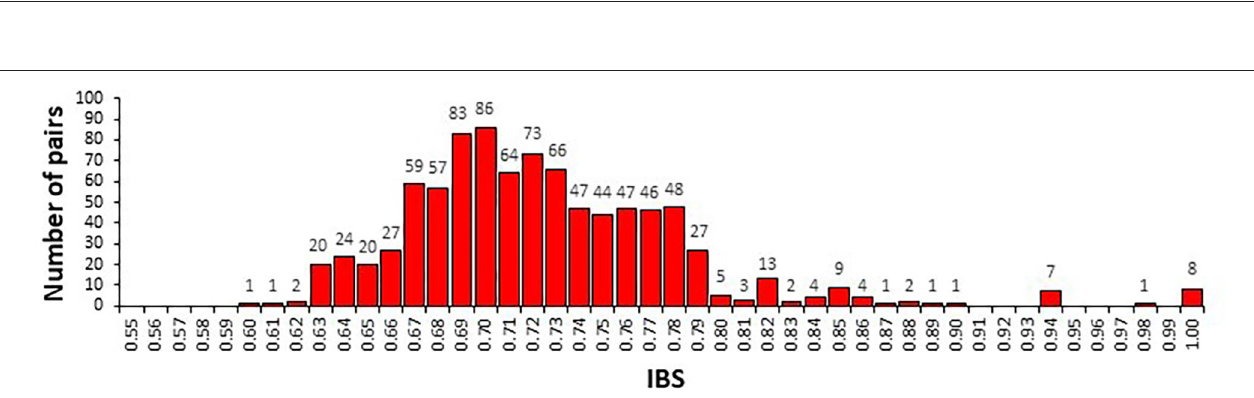
FIGURE 2 | Distribution of identity-by-state (IBS) allele sharing values among 43 durum wheat samples determined by the analysis of 5,555 SNP markers.